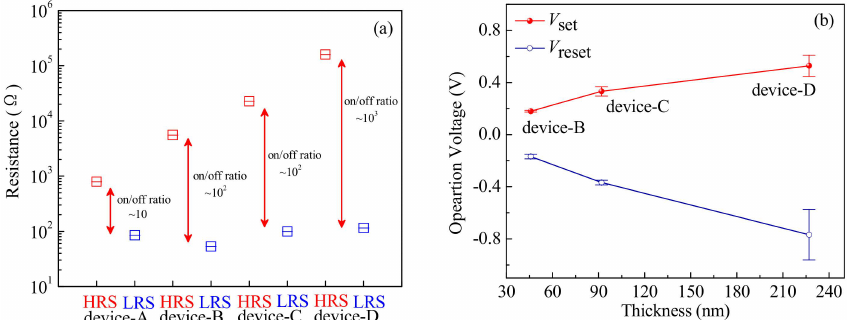
Figure 5. ( a ) Box plots of the high resistance state (HRS) and low resistance state (LRS) resistances of device-A, -B, -C and -D; ( b ) The switching voltage variation of device with di ff erent thickness Li-doped ZnO thin